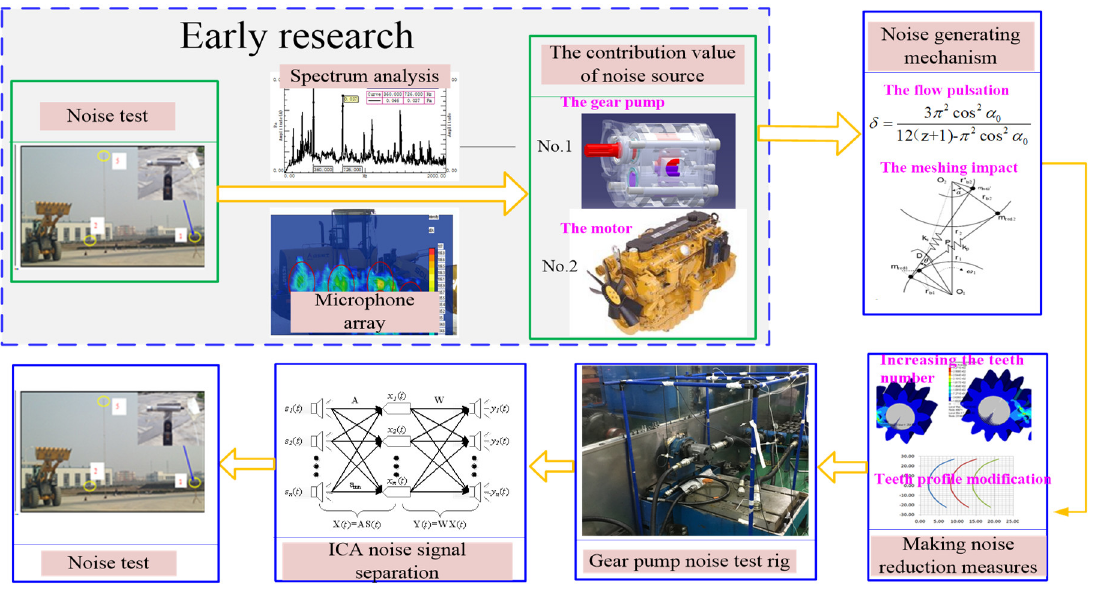
Figure 1. The main research contents.